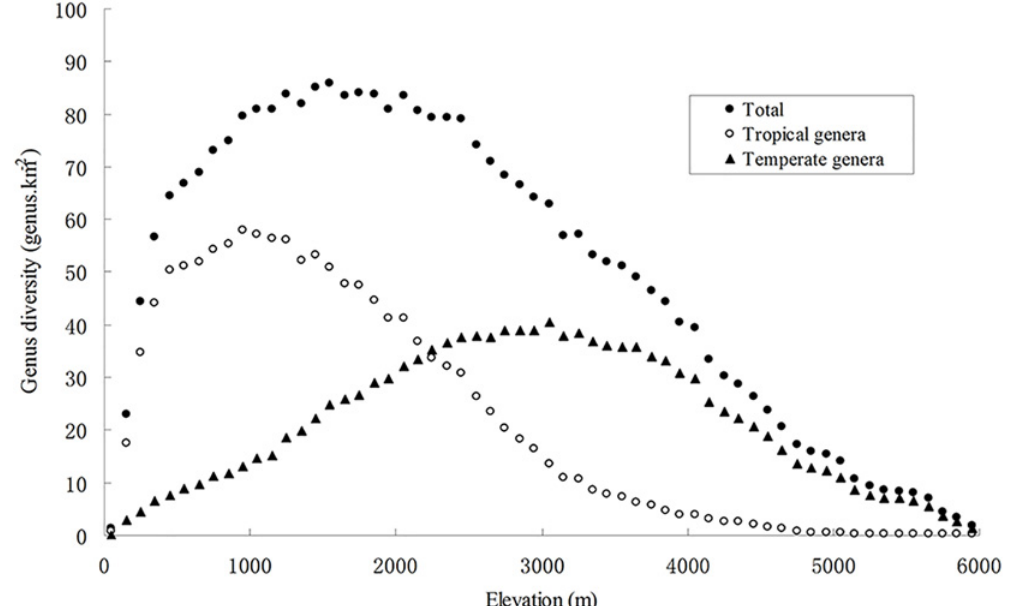
Fig 2. The relationship between genus diversity and elevation.